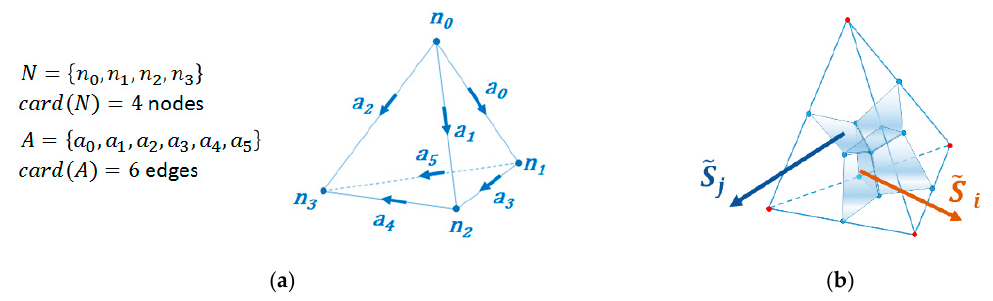
Figure 2 . ( a ) Tetrahedron with primal nodes and primal edges. ( b ) Tetrahedron with dual surfaces.